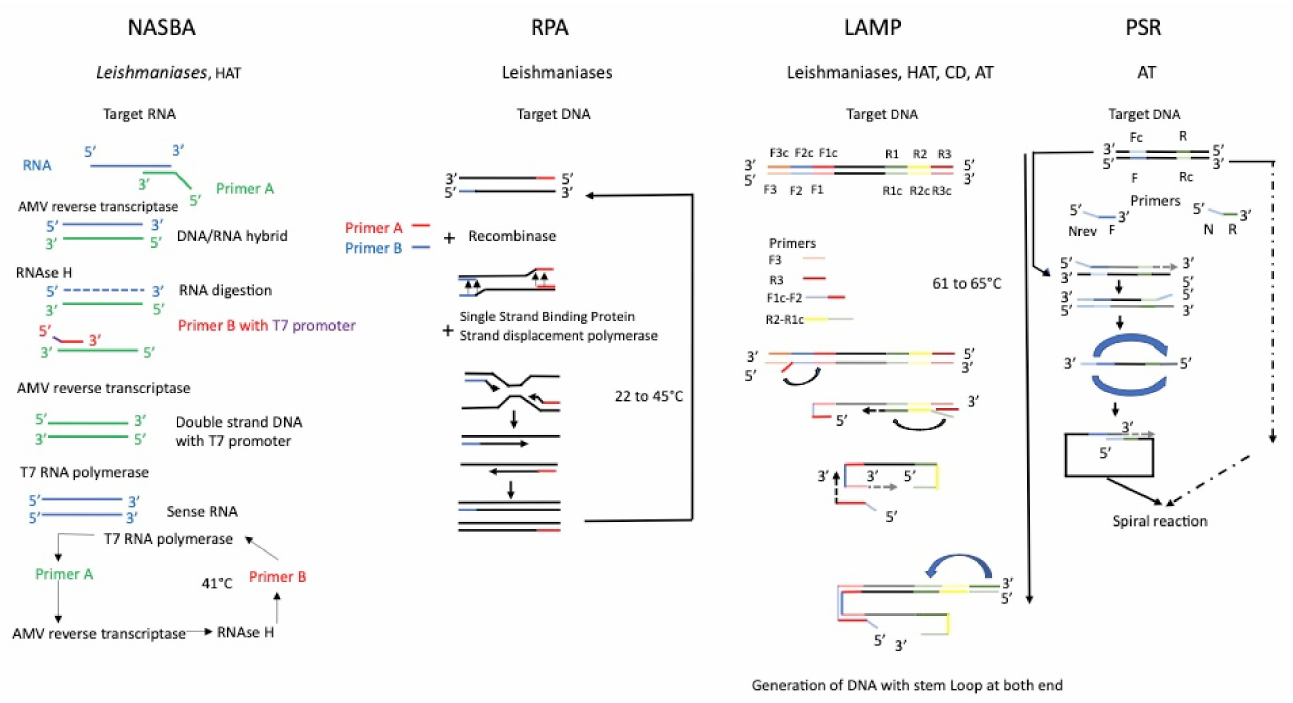
Figure 2. Schematic representation of isothermal amplification tested on Trypanosomatidae parasites. HAT—human African trypanosomosis; CD—Chagas disease, AT—animal